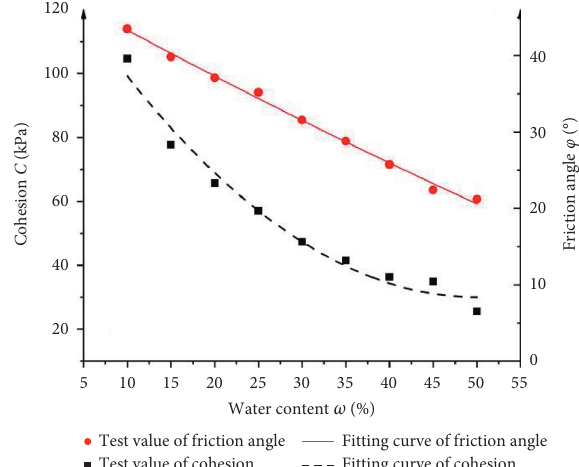
Figure 6: The relationships between the shear strength parameters and the water